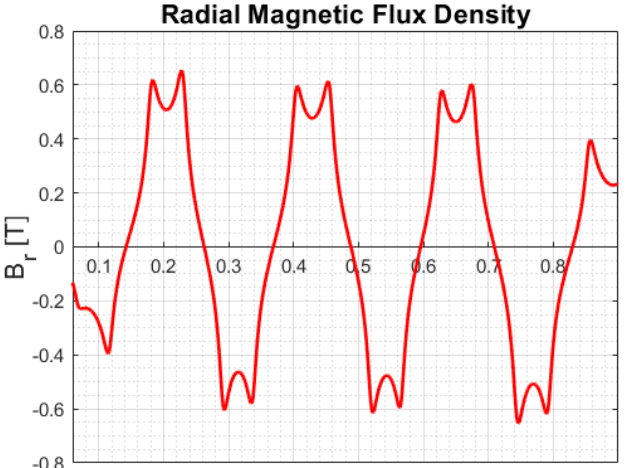
Figure 7. Reproduced predicted radial magnetic flux density profile along the conductor length at the midline of the air gap from ref. [46], used here for validation purpose.